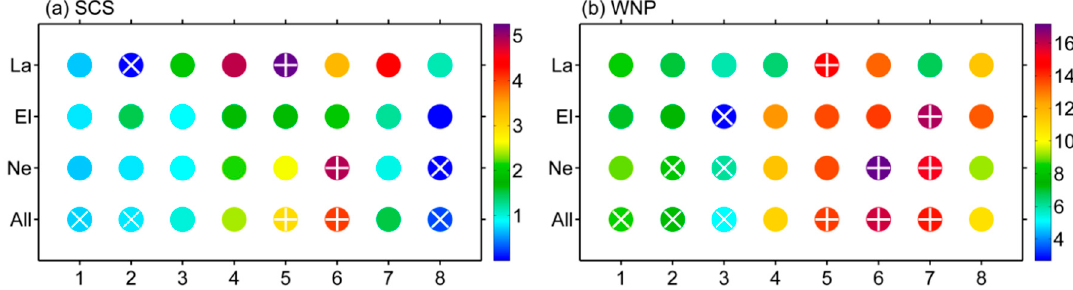
Figure 5. Daily genesis rate (DGR; unit: %) in each MJO phase for all years (All), neutral years (Ne), the El Niño years (El), and the La Niña years (La) over the ( a ) SCS and the ( b ) WNP during June–November over the period of 1979–2016. The phases in which TC numbers were statistically enhanced (suppressed) at the 90% significance level are indicated by + (×).